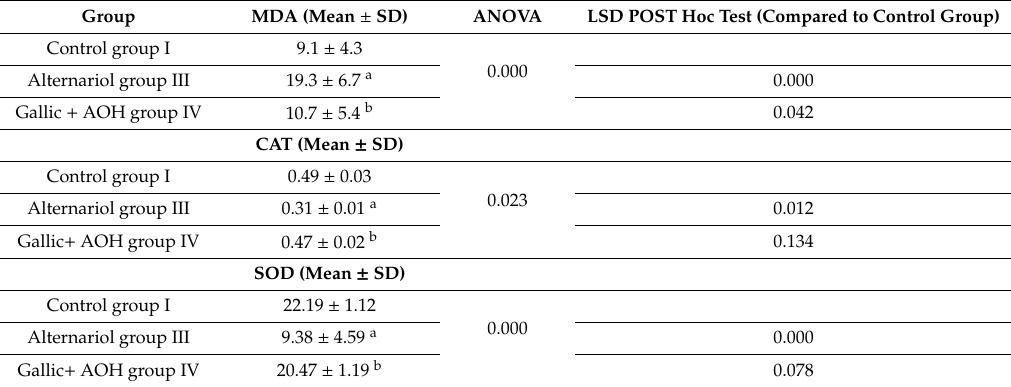
Table 3. Malondialdehyde (MDA), Catalase (CAT) and superoxide dismutase (SOD) and activity in di ff erent